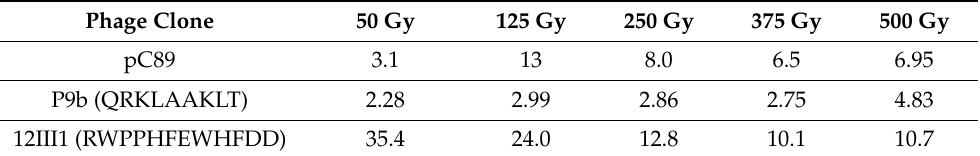
Table 3. Radiation damage (RD, × 10 − 3 Gy − 1 ) for each phage at different doses (Gy) of 5 MeV proton irradiation.